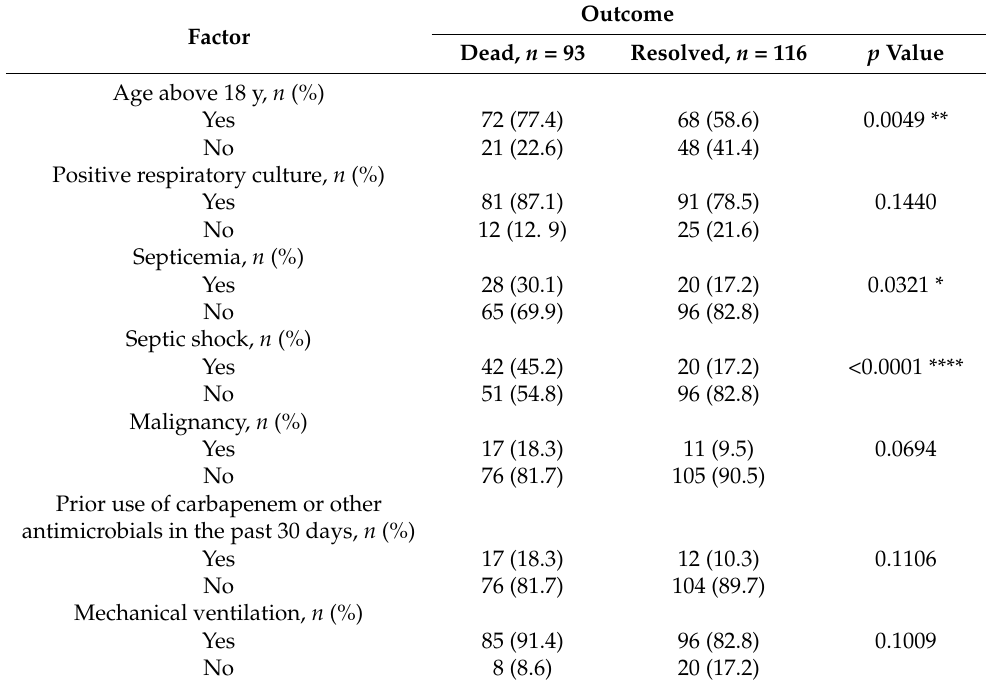
Table 3. Univariate analysis for factors associated with mortality of ICU patients with Stenotrophomonas maltophilia infections. Outcome Factor Dead, n =